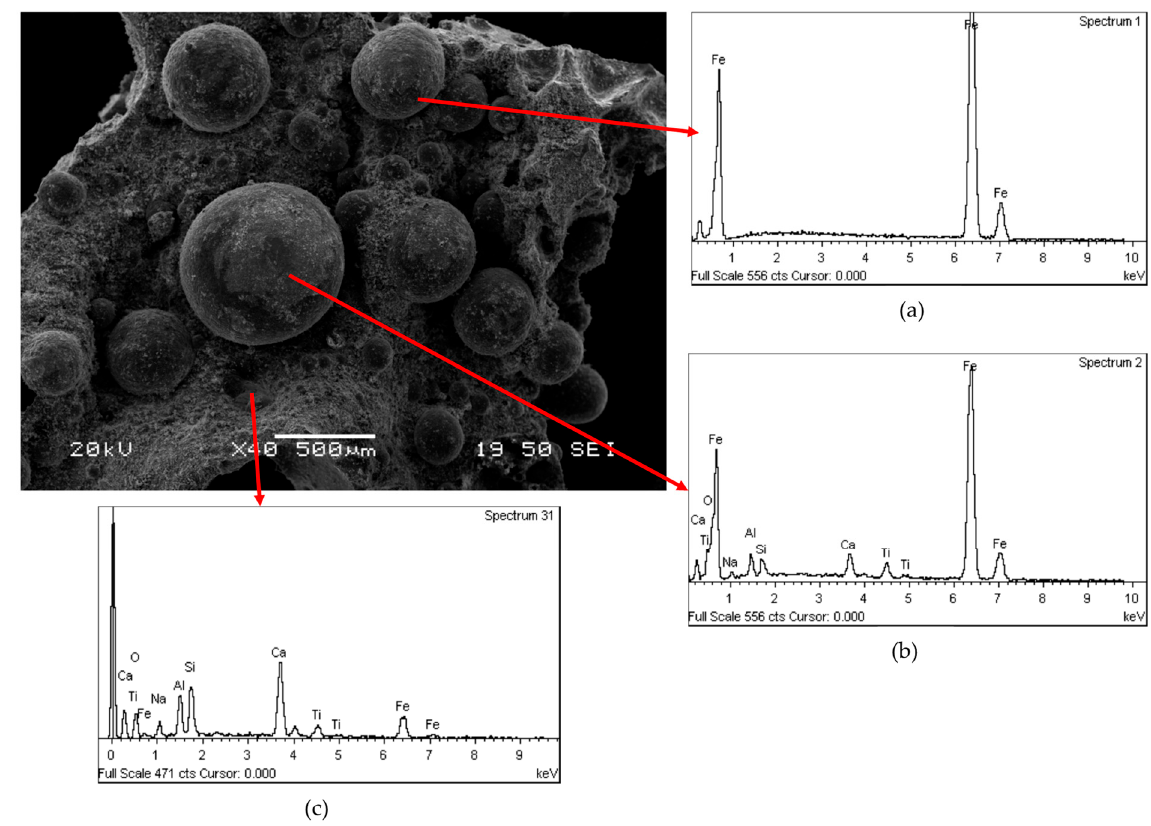
Figure 7. SEM-EDS analysis of cinder after the first microwave roasting reduction: ( a ) spherical metallic particles, ( b ) layer of powder on the metallic particles ( c ) matrix.